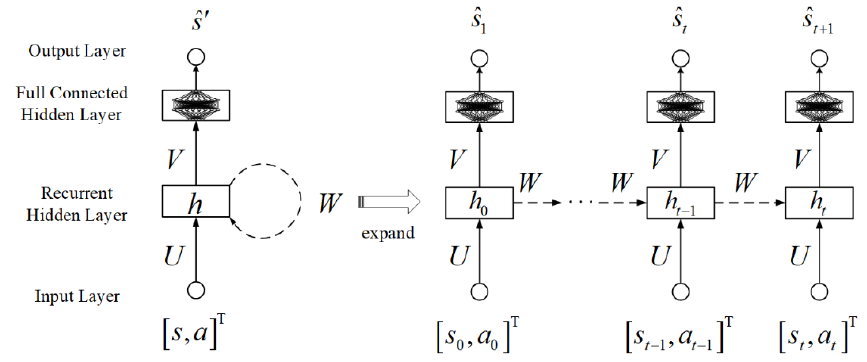
Figure 5. The network structure of the dynamic prediction model.